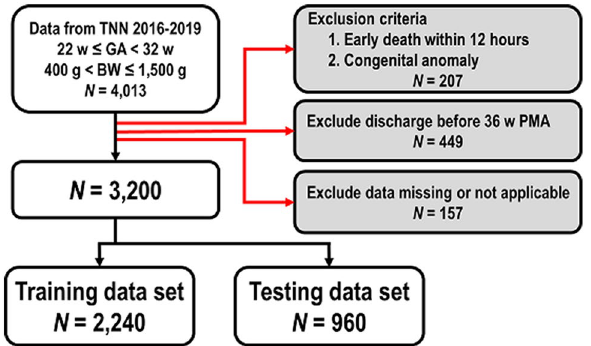
Figure 3. Patient selection flowchart. BW Birth weight; GA Gestational age; PMA Postmenstrual age; TNN Taiwan neonatal network.